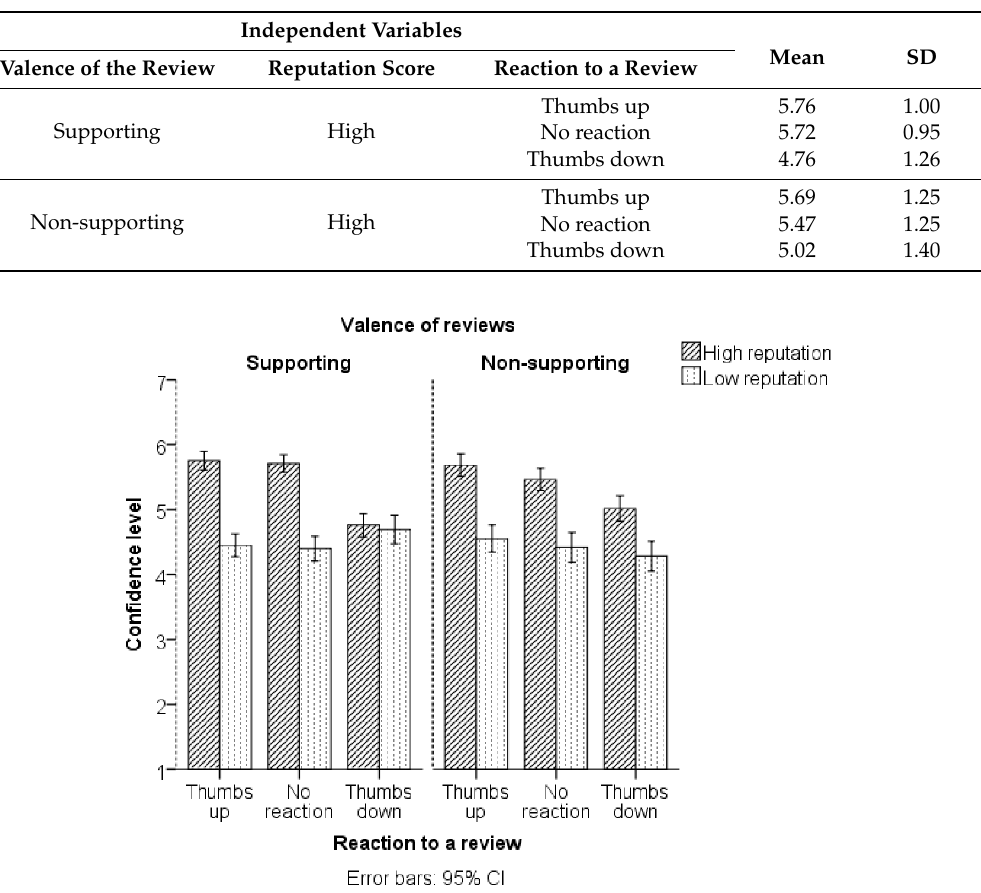
Figure 9. E ff ect of reaction to a review, reputation score and valence of reviews on confidence level.